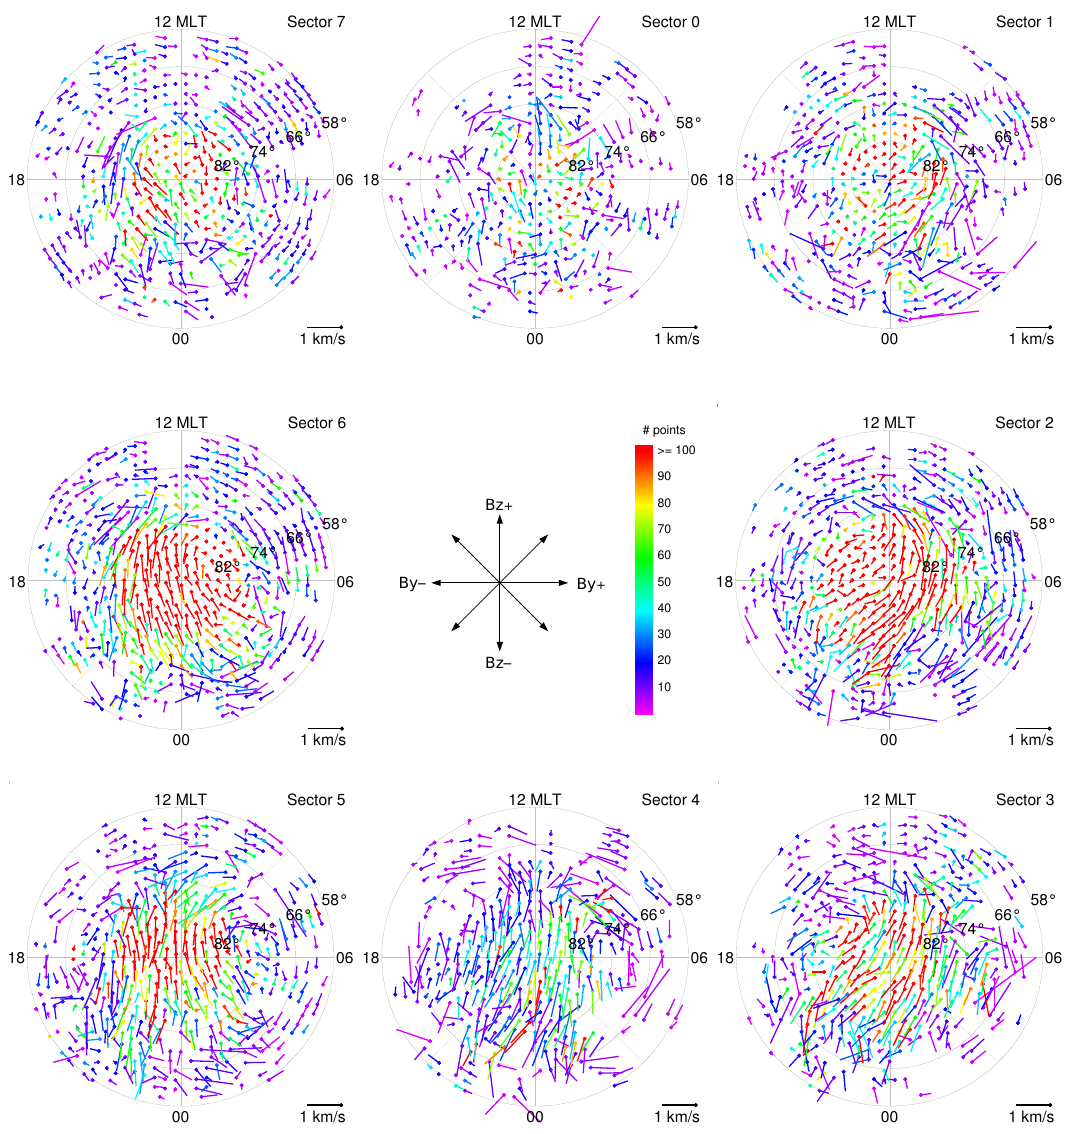
Fig. 6. Convection velocities for the Northern Hemisphere for each of the 8 IMF sectors, mapped into a 784 bin equal-area grid in SM coordinates in the ionosphere. The solid circles mark those grid points where at least three mapped EDI vectors were available for averaging. The number of samples per bin is indicated by the color code. The thin lines emanating from the grid points indicate the convection velocities. Latitude circles are shown at 58 ◦ , 66 ◦ , 74 ◦ , and 82 ◦ .